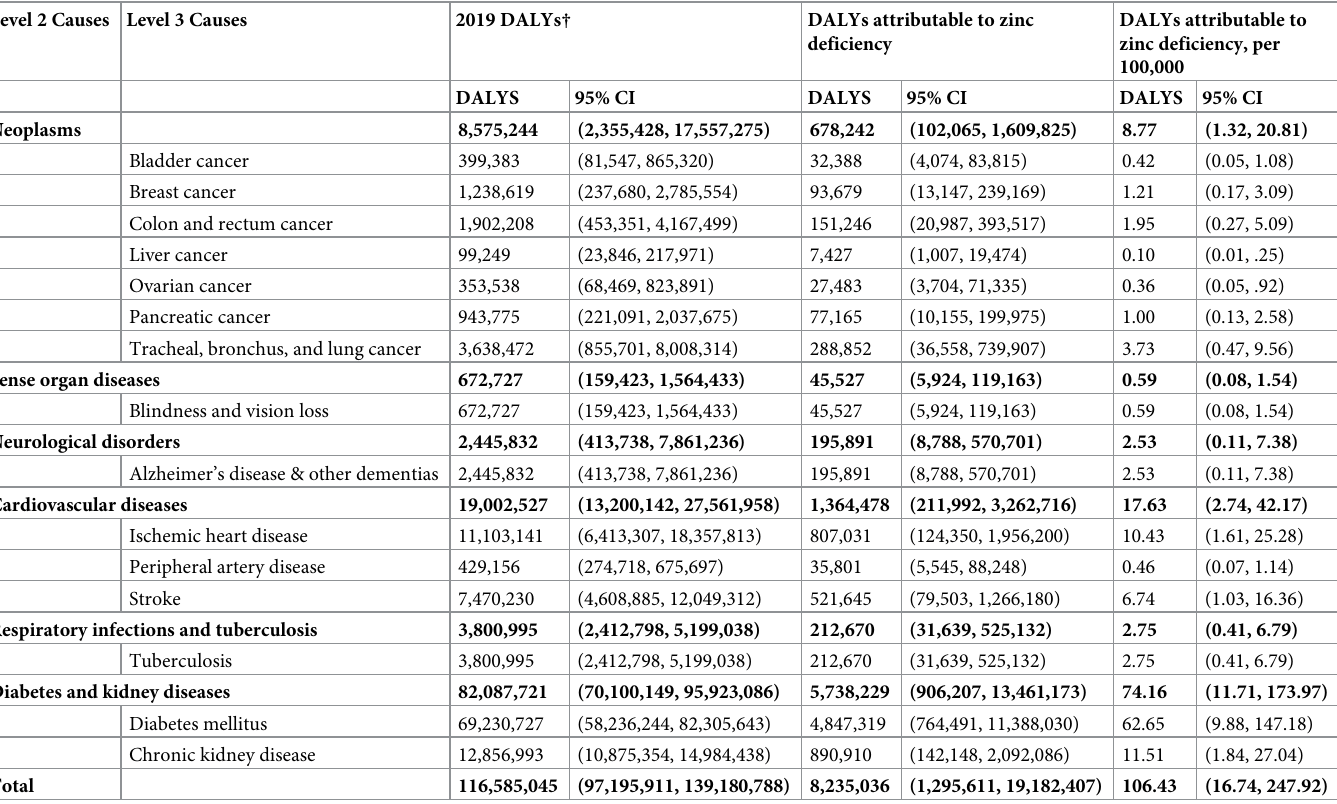
Table 3. DALYs from high FPG, and DALYs attributable to ZD at the global level by GBD level-3 causes, 2019 �